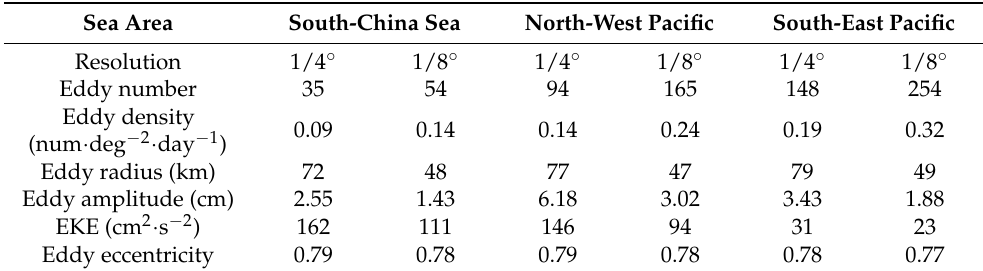
Table 5. Parameters of eddies in the three